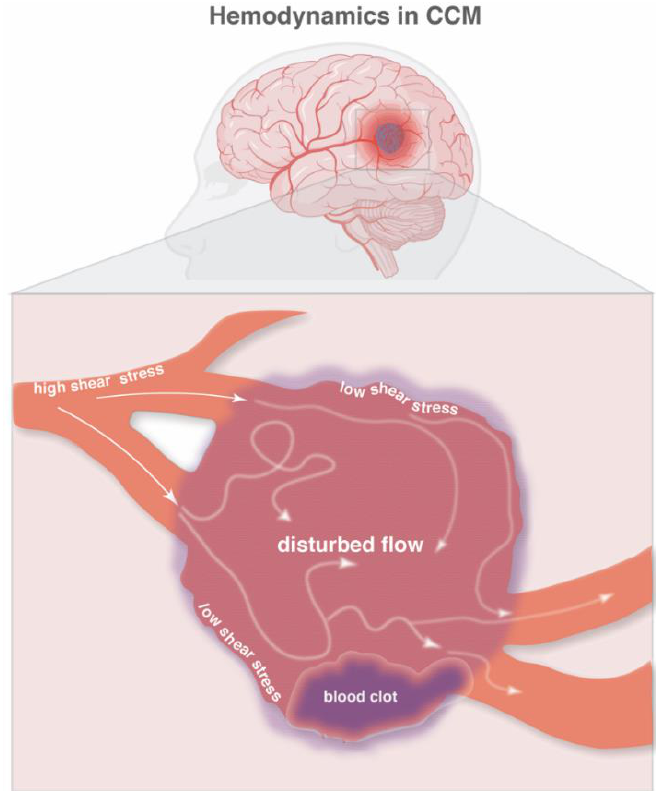
Figure 1. Hemodynamics in CCM . A schematic representation of blood flow in a cavernoma. Nor- mal blood flow (solid white arrows) results in high shear stress on endothelial cells while disturbed blood flow (diffused white arrows) results in low shear stress on endothelial cells. A blood clot (dark purple) may further disturb the already reduced blood flow in the cavernoma. In addition, a blood clot may also obstruct nearby blood vessels and further reduce blood flow. The figure was assembled with Adobe Illustrator and BioRender (agreement number QG24D9MLOD).